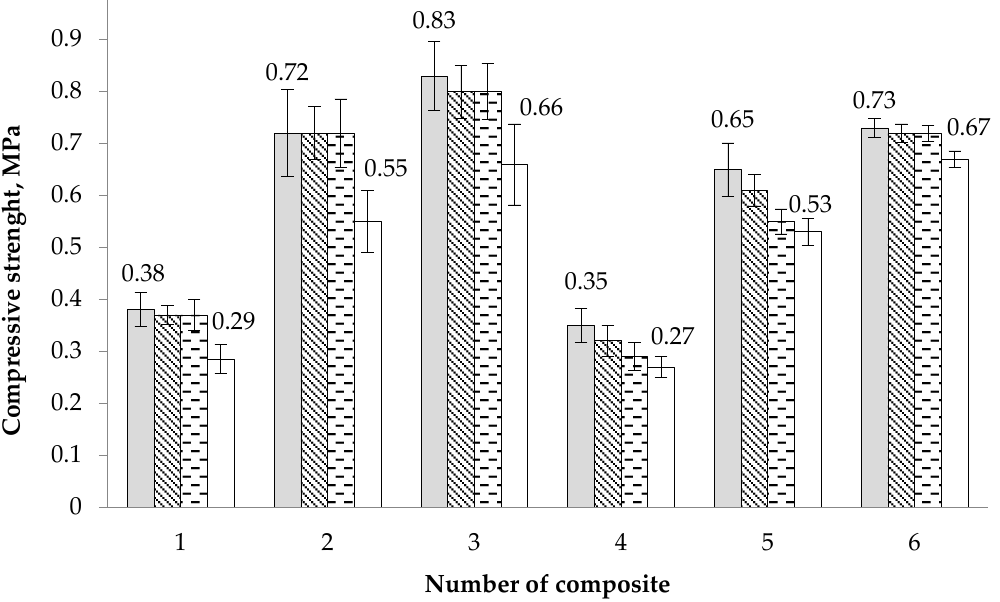
Figure 9. Compressive strength of the control specimens and after 25, 100, and 200 freeze–thaw cycles. Table 8. Changes in compressive strength after 25, 100, and 200 freeze–thaw cycles.